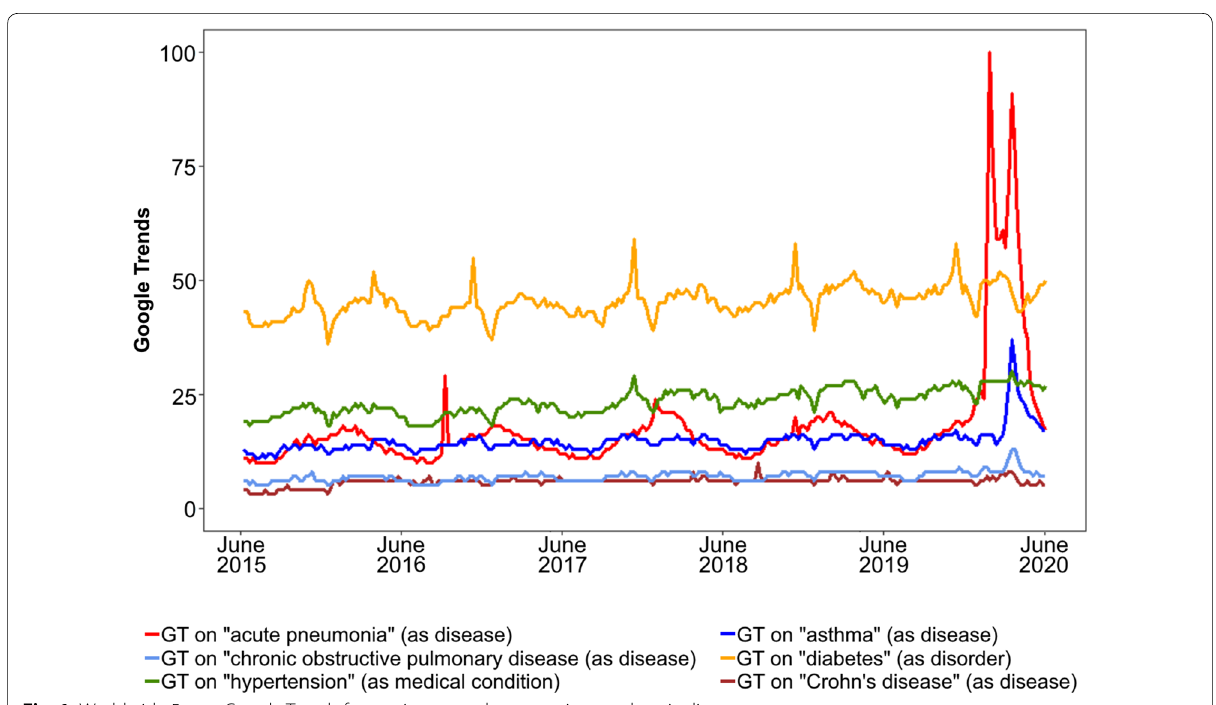
Fig. 1 Worldwide 5‑year Google Trends for respiratory and non‑respiratory chronic